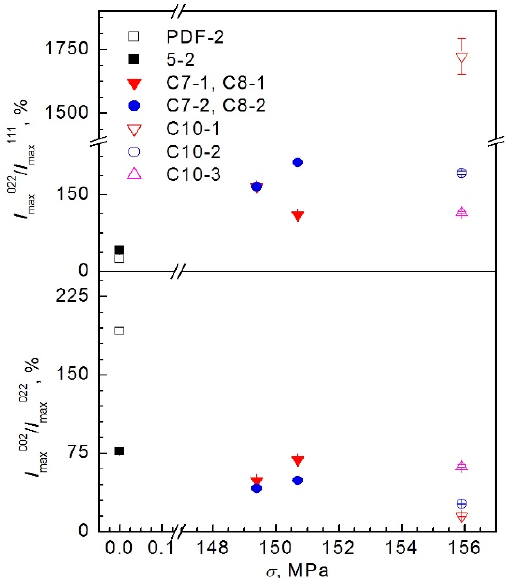
Figure 4. Dependence of the ratio of the maximum intensities ( a ) I max022 / I max111 of reflections 022 and 111 and ( b ) I max002 / I max022 of reflections 002 and 022 on the load σ during cyclic loading of the samples. The designation “PDF-2” corresponds to the data of the powder database map PDF-2 01-071-4008 [26] at a temperature T = 312.3 K, which is close to the temperature of XRD measurements, T = 314 ± 1 K.